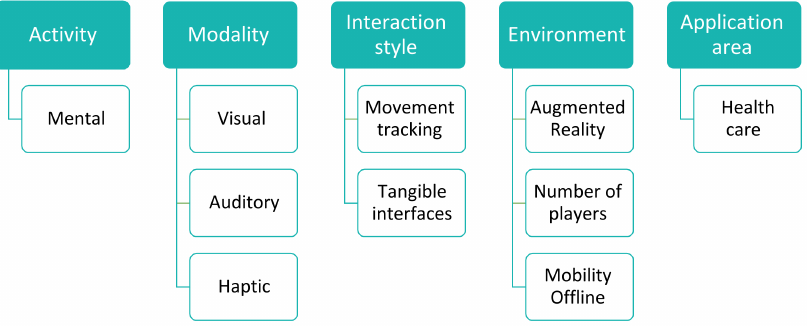
Figure 19. Serious Games Criteria for Future